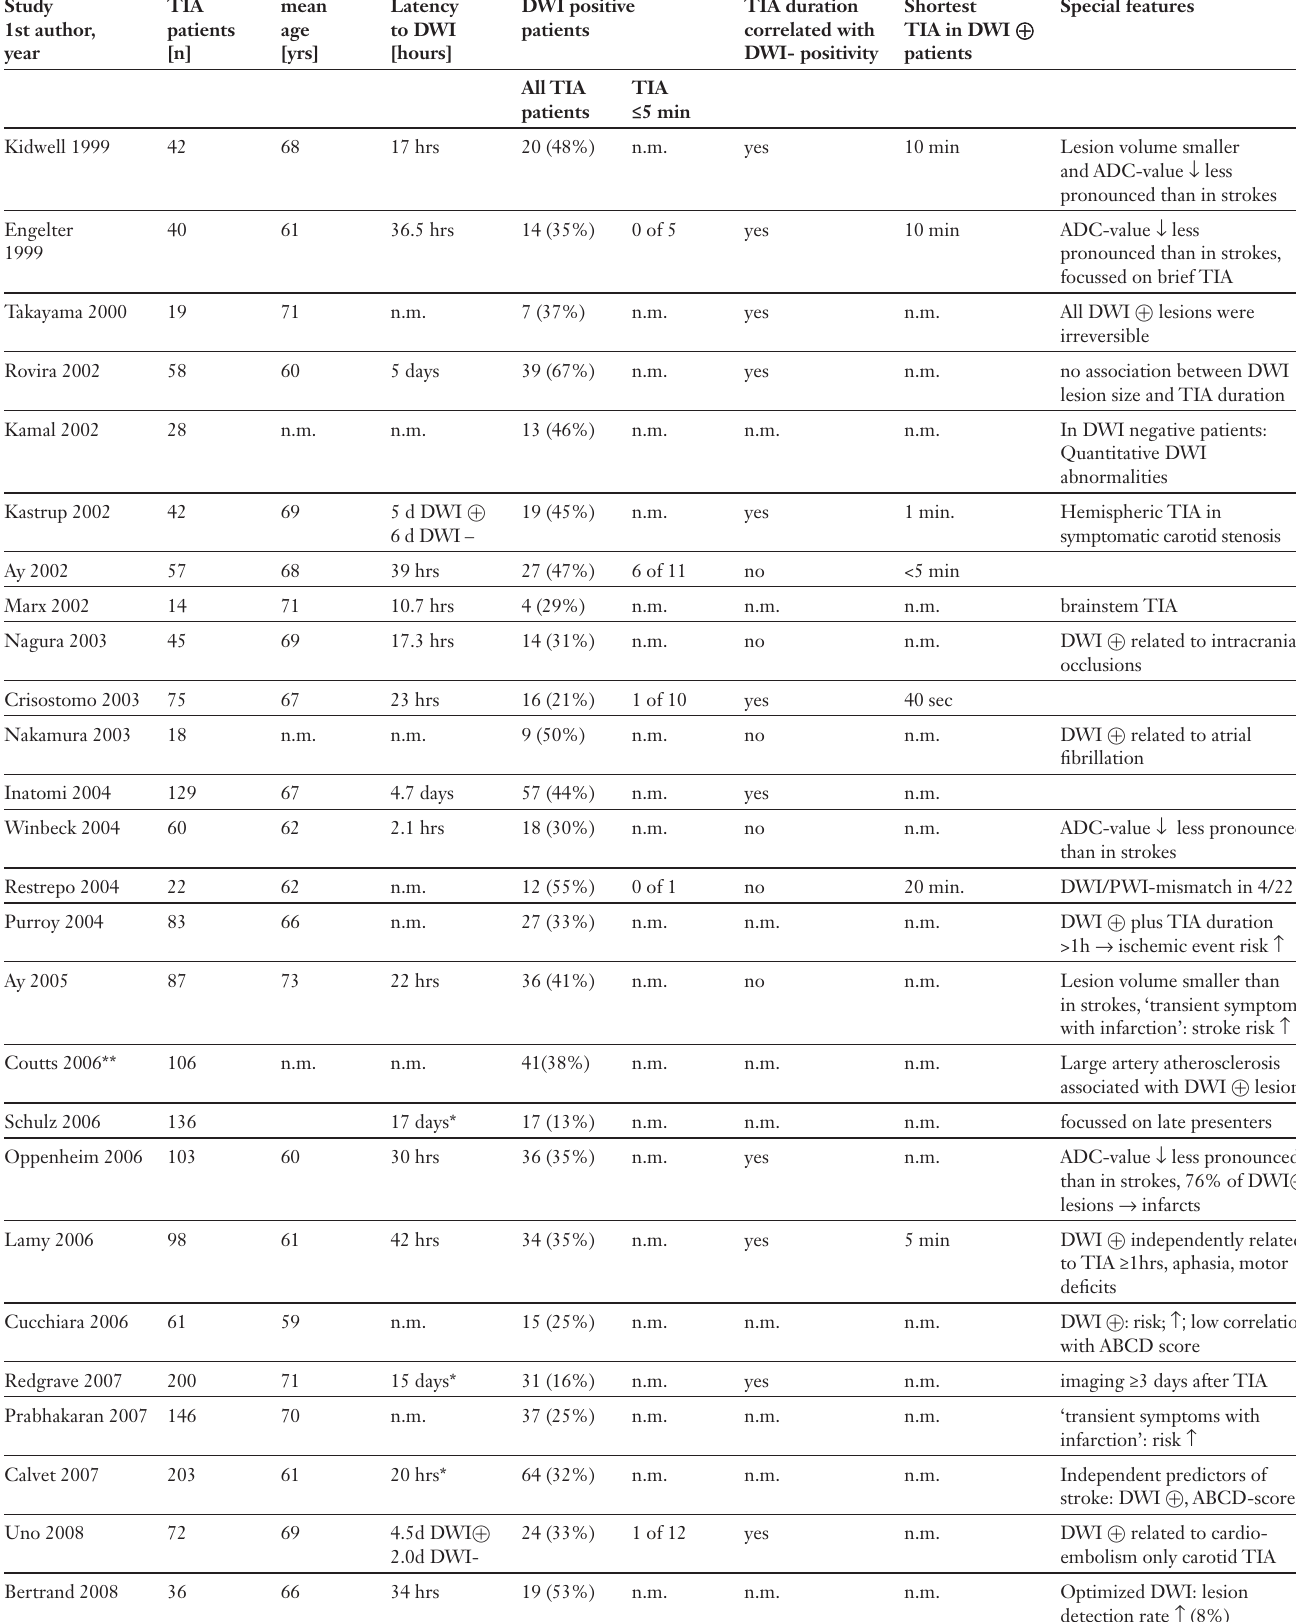
Summary of studies about diffusion-weighted MR imaging in TIA patients [15, 16,